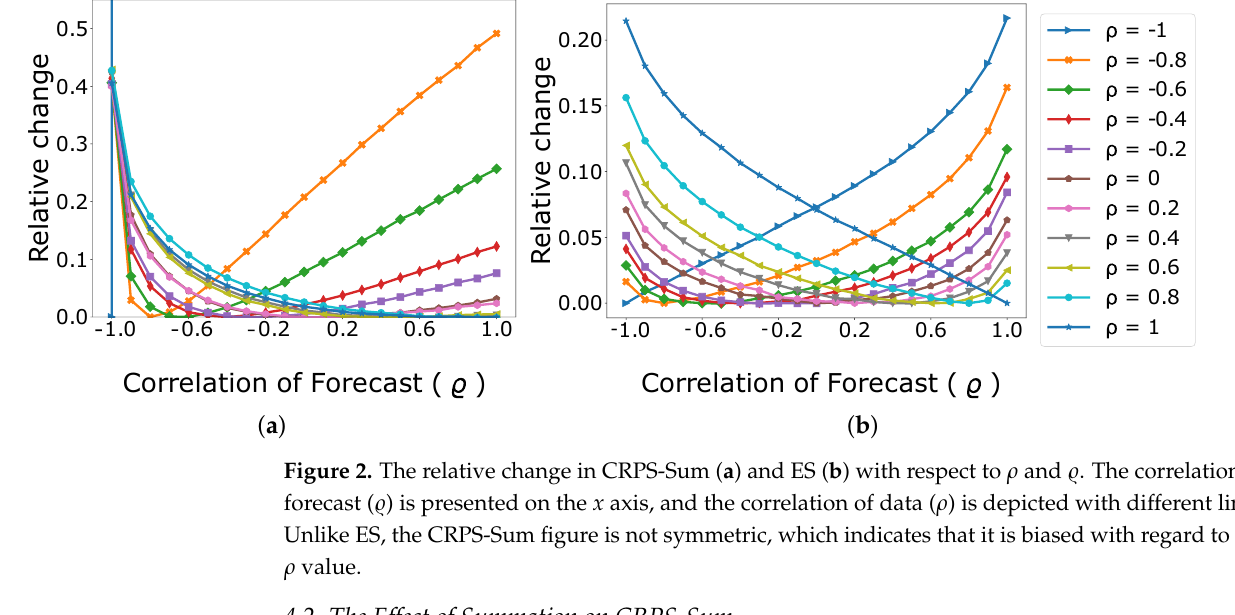
Figure 2. The relative change in CRPS-Sum ( a ) and ES ( b ) with respect to ρ and (cid:36) . The correlation of forecast ( (cid:36) ) is presented on the x axis, and the correlation of data ( ρ ) is depicted with different lines. Unlike ES, the CRPS-Sum figure is not symmetric, which indicates that it is biased with regard to the ρ